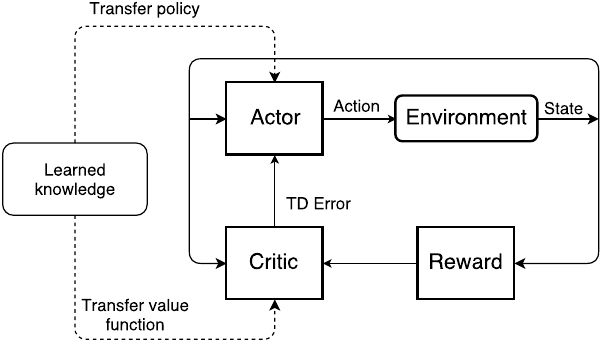
Figure 6. The transfer learning actor–critic